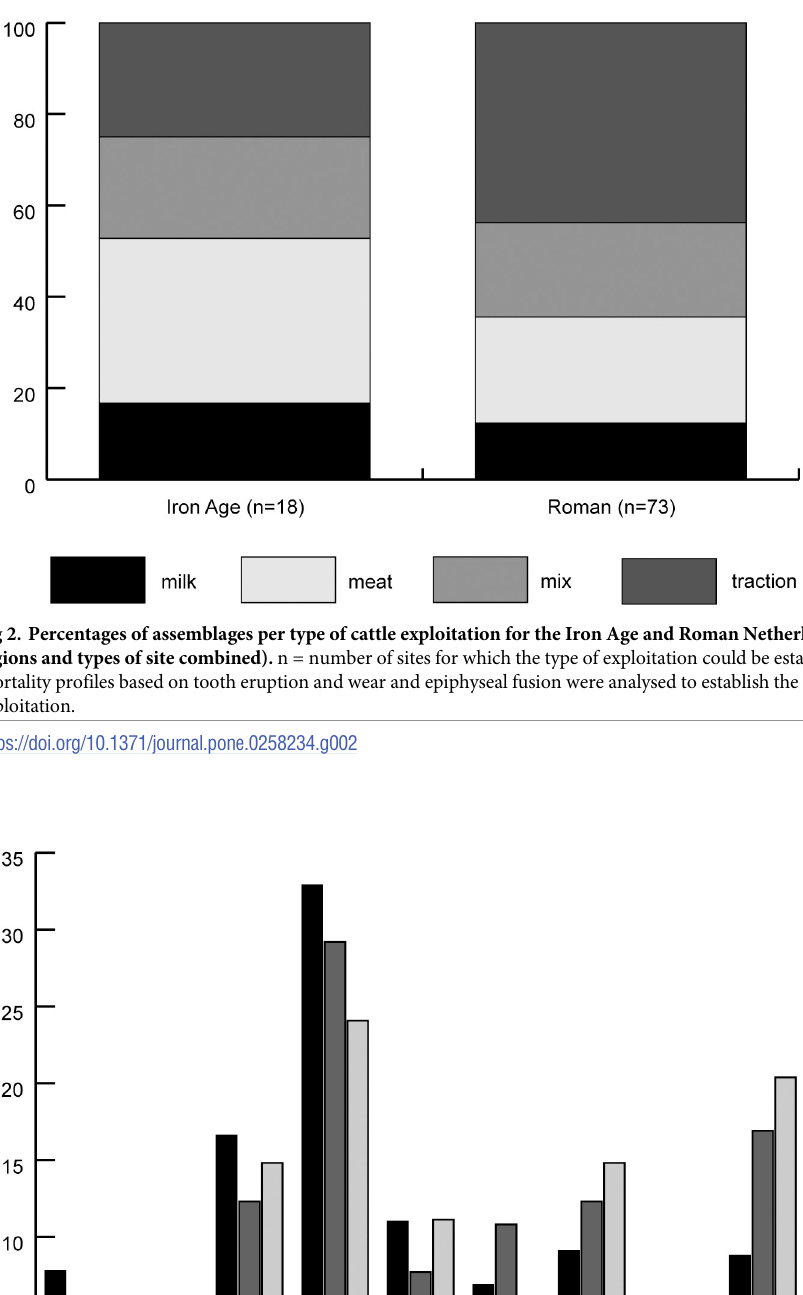
PLOS ONE | https://doi.org/10.1371/journal.pone.0258234 October 1,